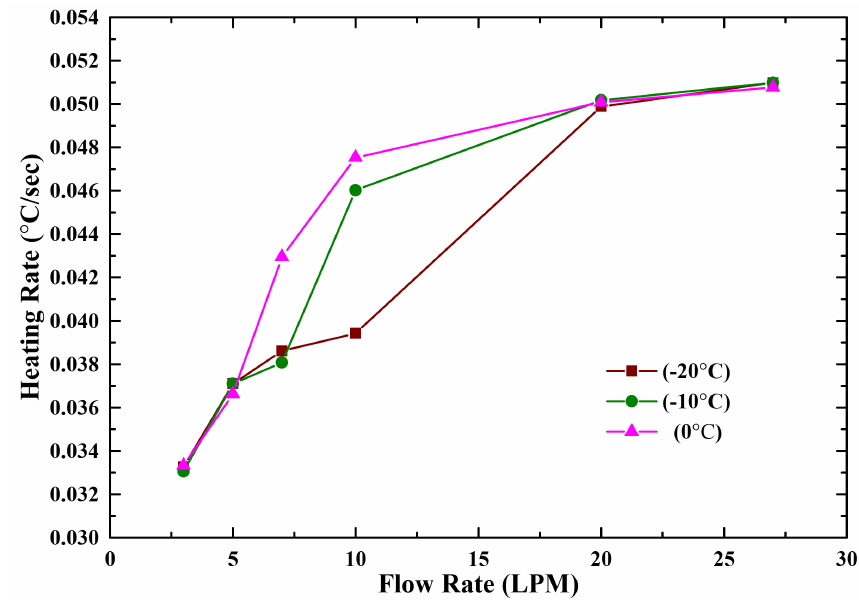
Figure 9. Heating rate as a function of flow rate with heater capacity: 4